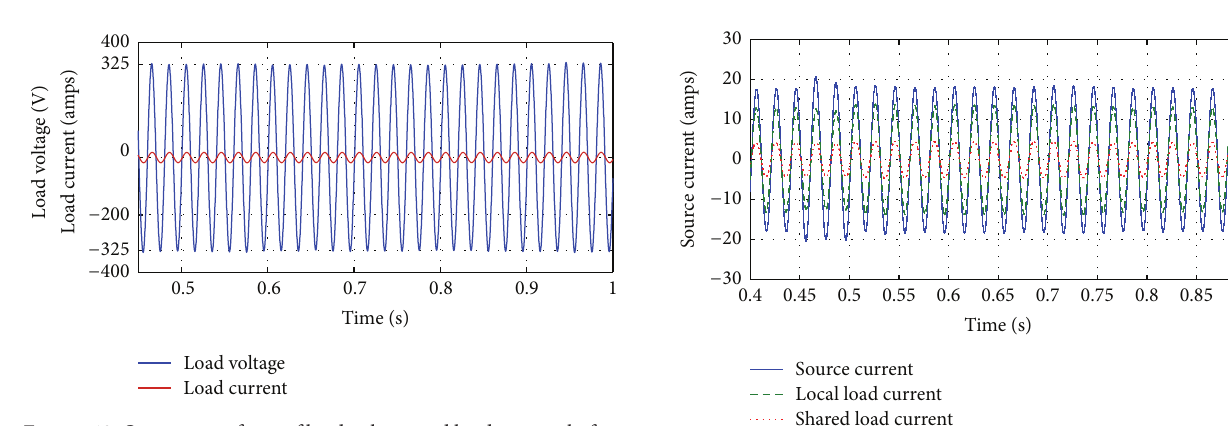
Figure 10: Output waveform of load voltage and load current before fault.